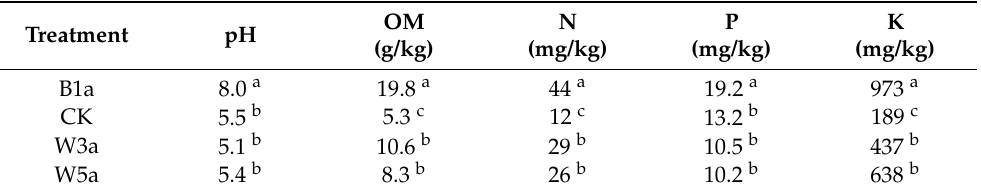
Table 2. Soil physicochemical analysis.